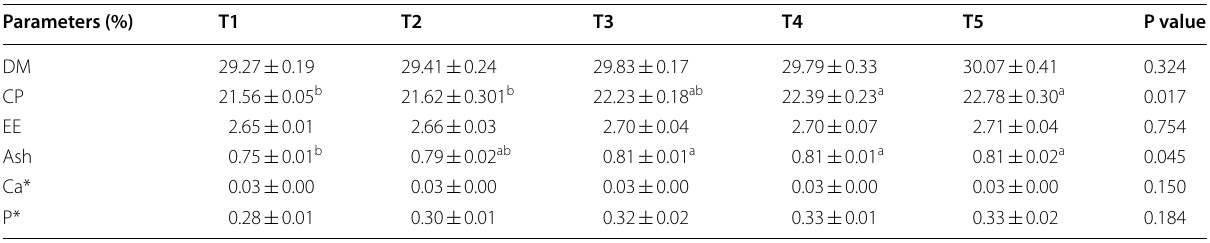
T1, basal diet with no additives; T2, basal diet supplemented with citric acid (10 g/kg) and no whey; T3, T2 T5, T2 whey powder (22.5 g/kg) + * On dry matter basis a,b Means within the same row carrying different superscripts are significantly different at (P